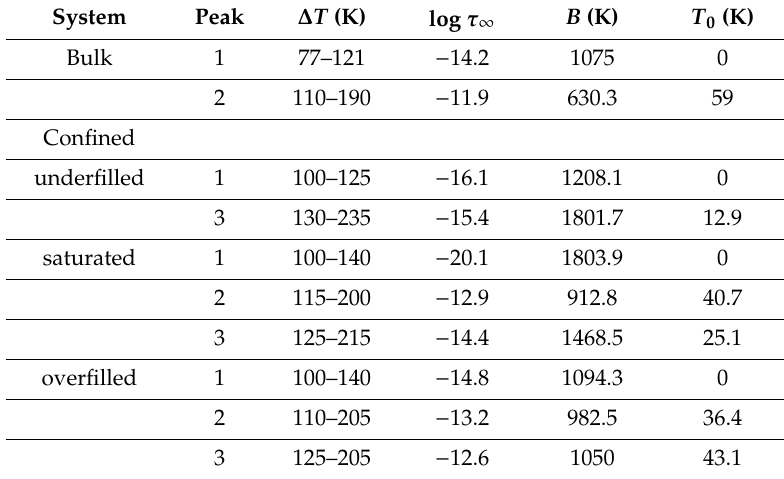
Figure 7. Arrhenius plot of the maximum relaxation times in all the three variously filled n-PrOH / MCM-41, N 2 systems, determined from the unimodal spectra for the underfilled n-PrOH / MCM-41, N 2 system and from the bimodal ones for the saturated and overfilled n-PrOH / MCM-41, N 2 ones, together with the corresponding VFTH equation fits with parameters in Table 2. Table 2. Fitting parameters from the VFTH equation: τ max = τ ∞ exp[ B / ( T − T 0 )] for the main peak features (peaks 3 and 2) and the Arrhenius equation: τ max = τ ∞ exp[ B/T ] for the secondary peak one (peak 1) in the bulk n-PrOH and the confined n-PrOH/MCM-41, N 2 systems.